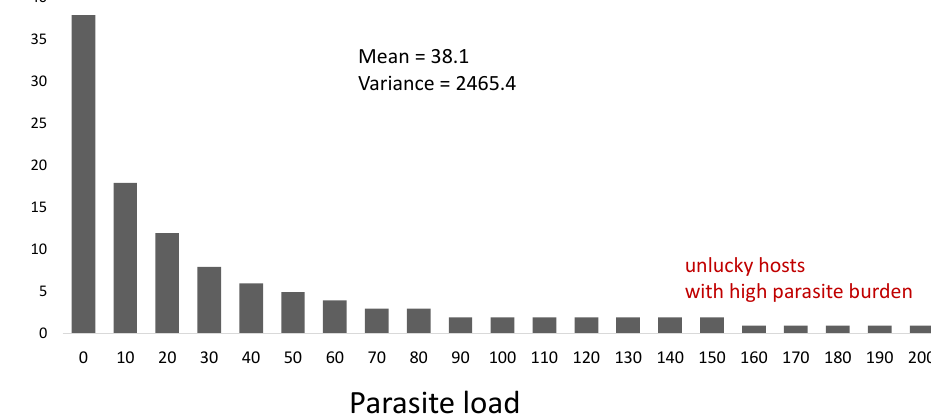
Figure 2. Example distribution where there is parasite aggregation in host population. Variance > Mean. In this distribution, many have zero or low parasite burden, and only a few have high parasite burden.